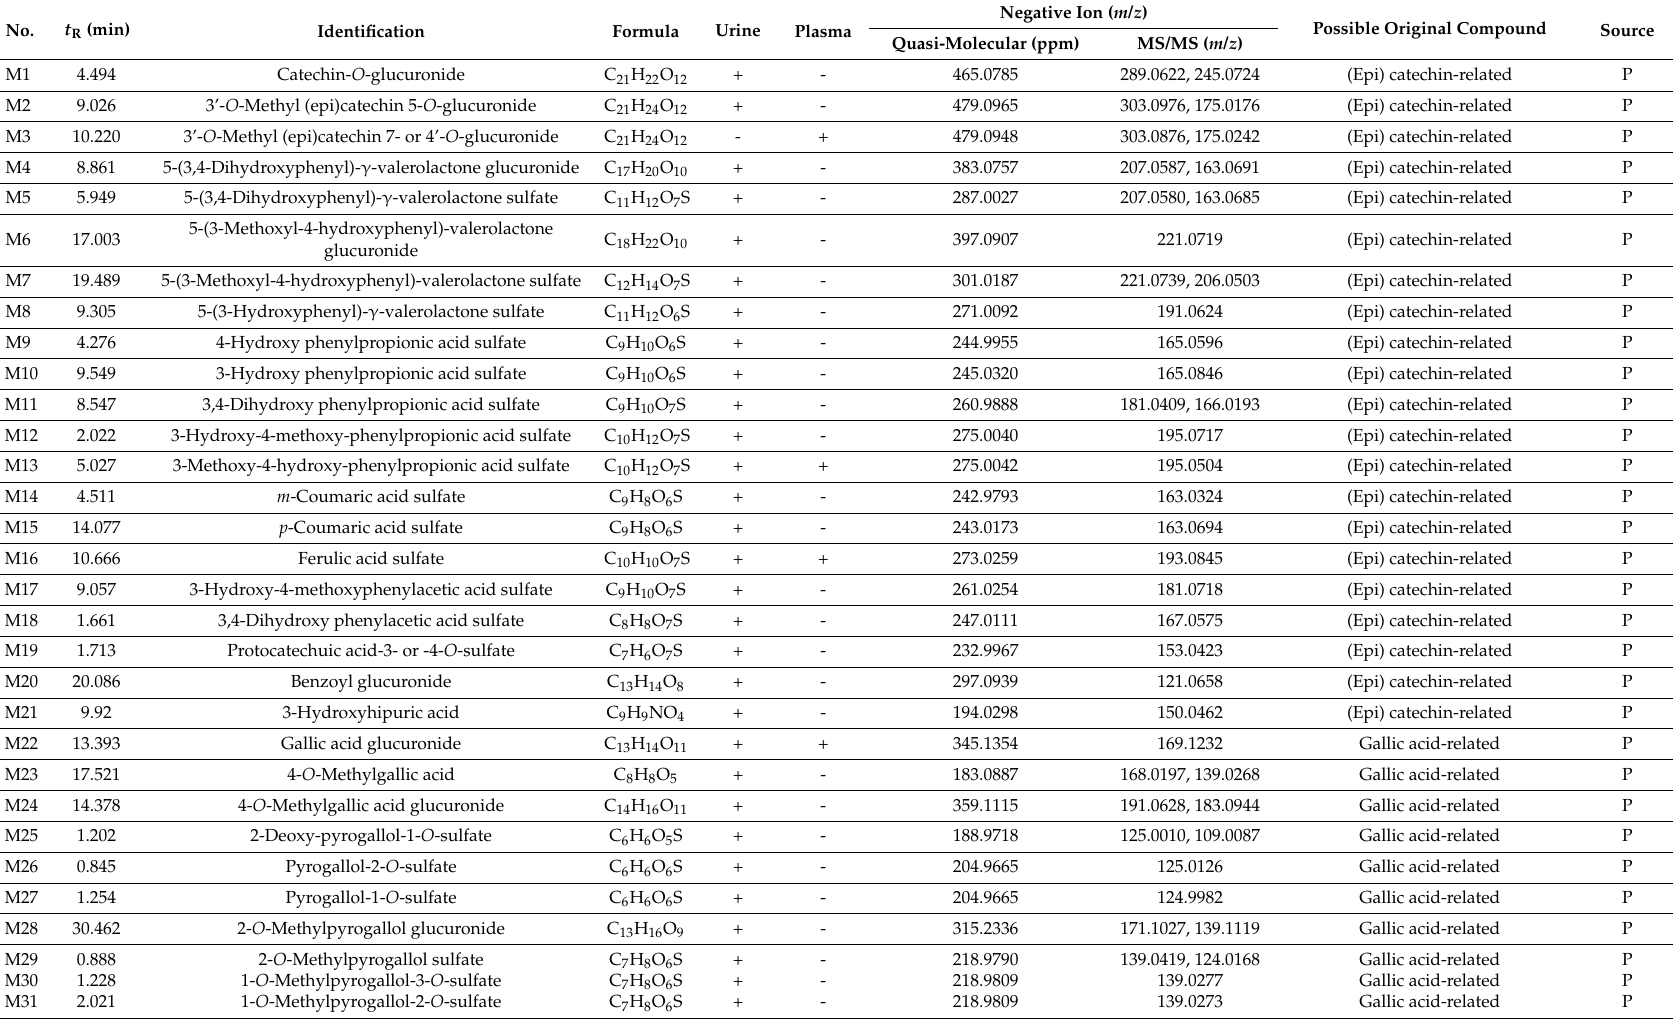
Table 2. Identification and detection of metabolites of GZD in rat plasma and urine samples by